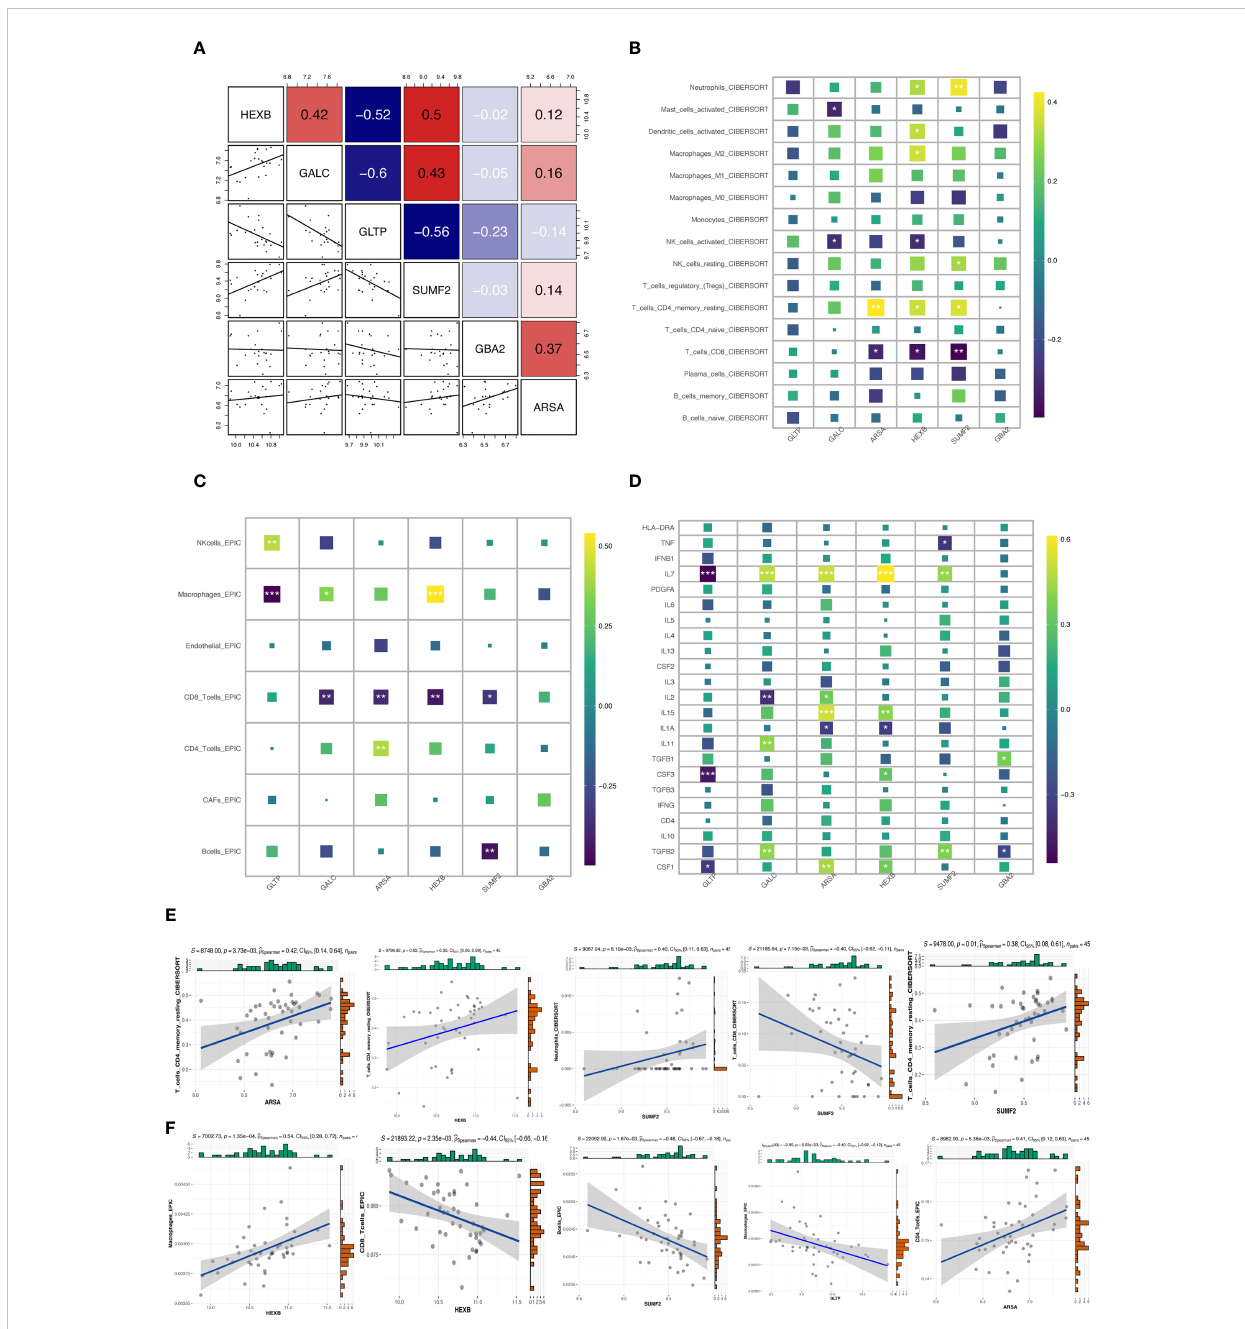
FIGURE 4 Correlation between candidate genes and immune cell in fi ltration. (A) Co-expression patterns of 6 GSMRG in all samples based on the Pearson correlation analysis. (B, C) Heatmap of correlation between 6 GSMRG and immune cell in fi ltration in Cibersort and EPIC algorithm. (D) Heatmap of correlation between GSMRG and in fl ammatory factors. (E – F) Top 5 correlation plots in Cibersort and EPIC algorithm. *p < 0.05, **p < 0.01, ***p <